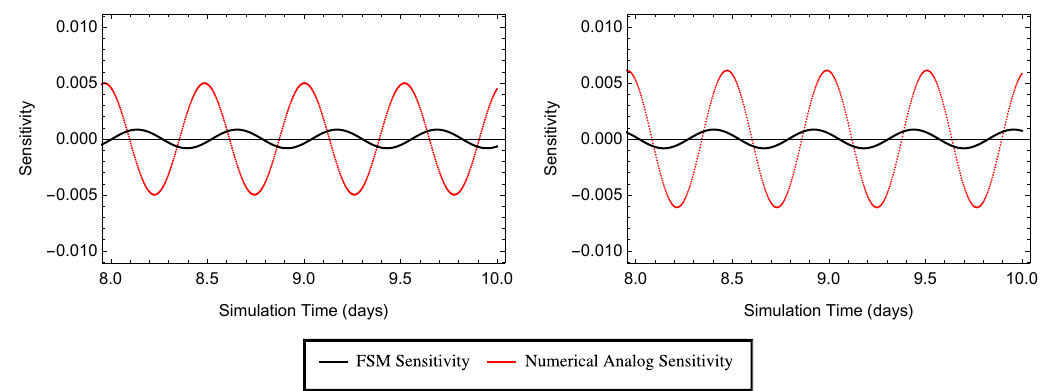
Figure 10. Numerical analog sensitivity (red) between implicit 1D results with G= 0.001 s − 1 and G = 0.1 s − 1 and FSM sensitivity (black) for G = 0.1 s − 1 for the 11th ( left panel ) and 12th ( right panel ) nodes in the linear sloping domain.